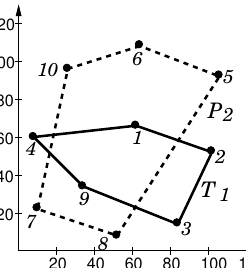
= ( 4,10,1,2,3,9,4 ) ; ( b ) T 2 = ( 4,10,6,1,2,3,9,4 ) ; ( c ) T 3 h − 1 h − 1 h − 1